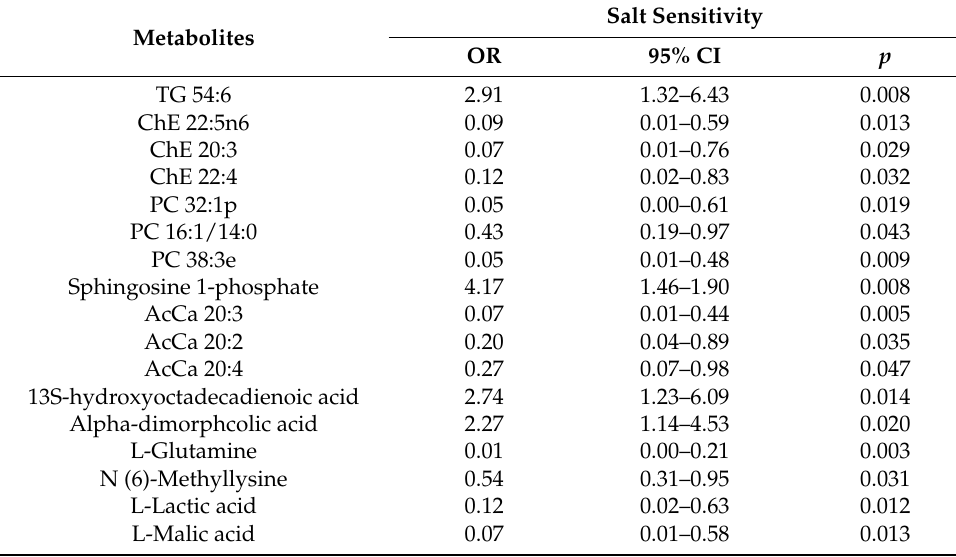
Table 2. Results of metabolites related regression models for SS.